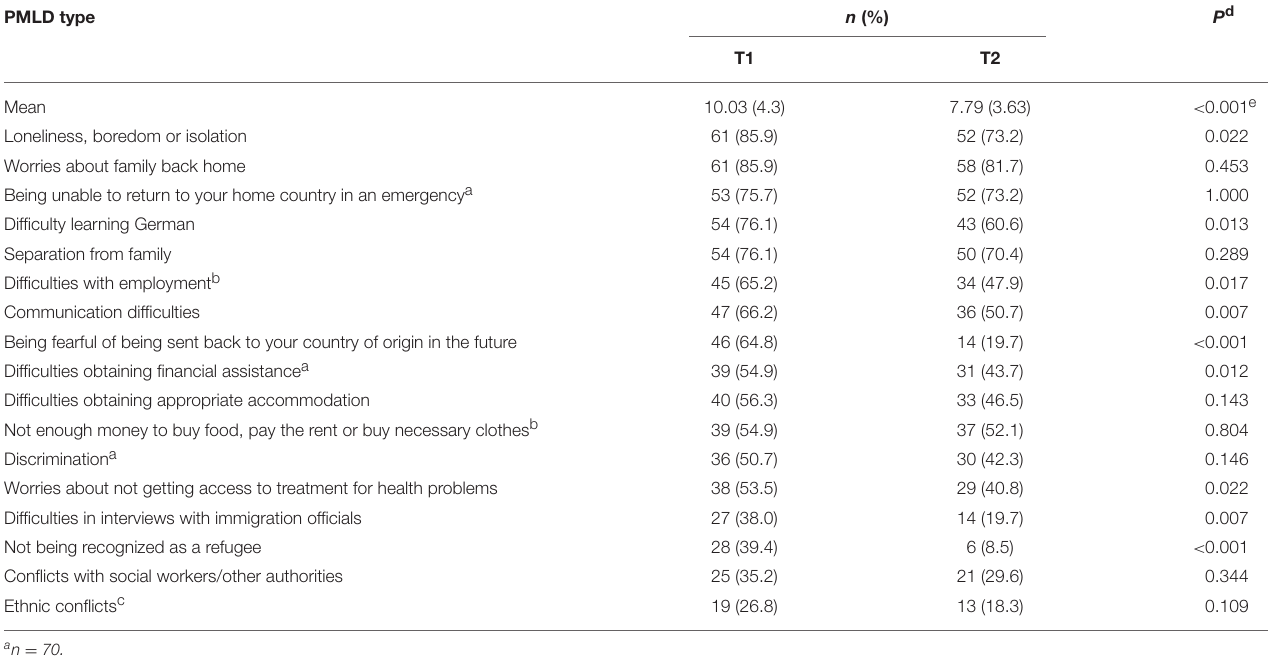
TABLE 3 | Post-migration Living Difficulties experienced as moderately serious, serious or very serious ( N = 71). PMLD type